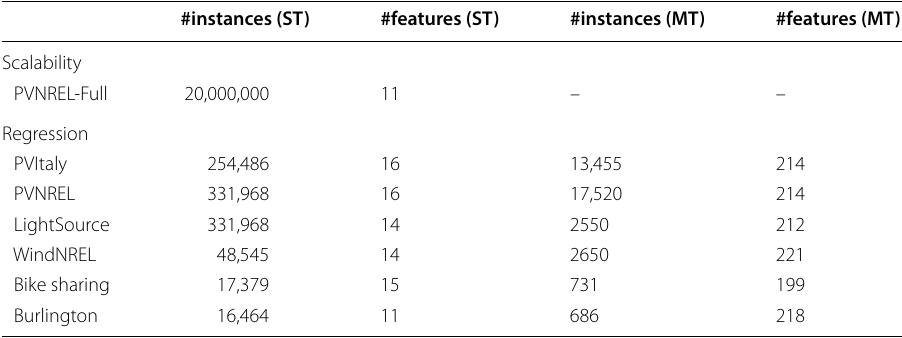
Table 2 Quantitative information on the datasets used for the scalability analysis and for the single-target (ST) and multi-target (MT) regression